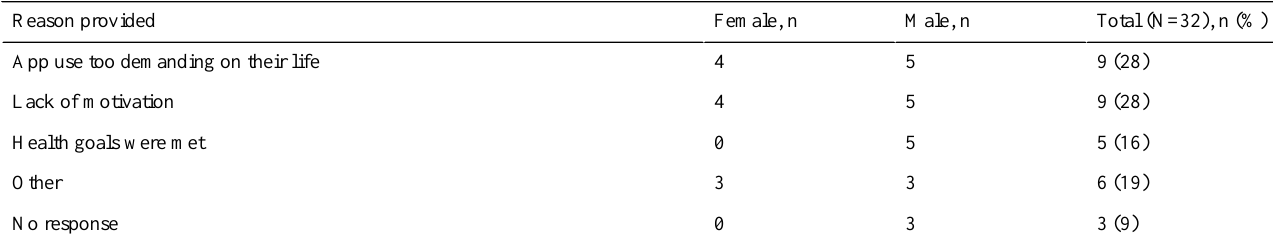
Table 2. Reasons provided for app nonuse.